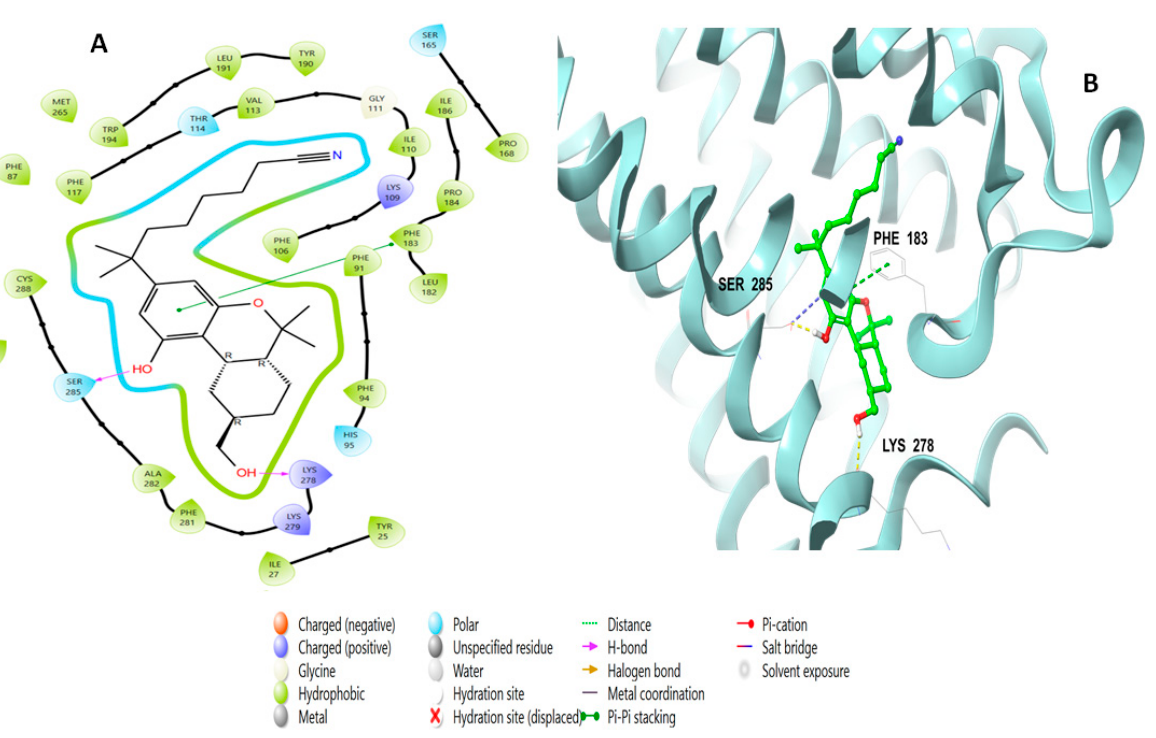
Figure 3. Chemical structure of depsidones with higher docking scores.